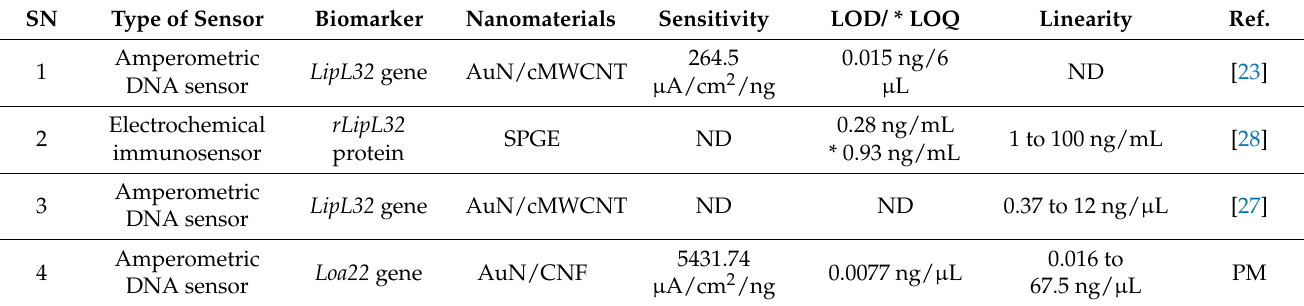
Table 2. Comparison of the different types of biosensors developed for the detection of leptospirosis with the present method based on the Loa22 gene of Leptospira